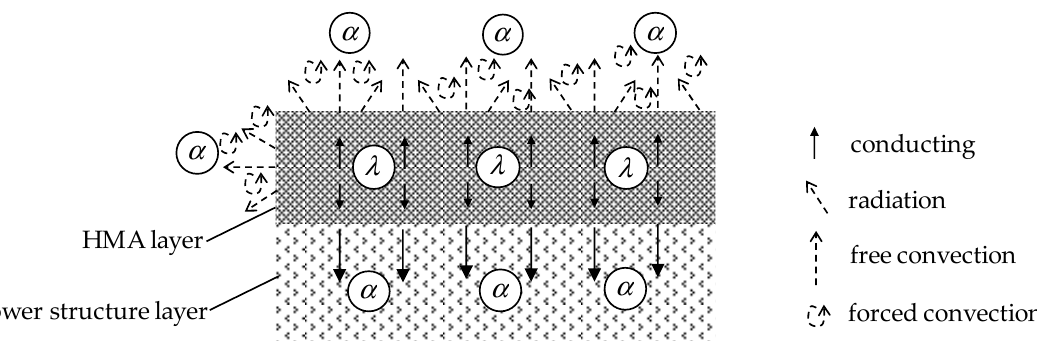
convection and laminar flow and for boiling).